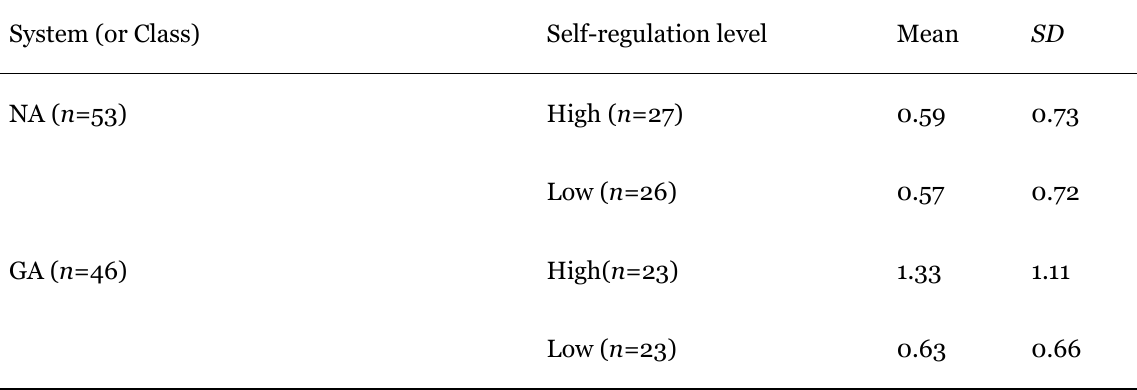
Descriptive Statistics of Requesting Rate (n=99)